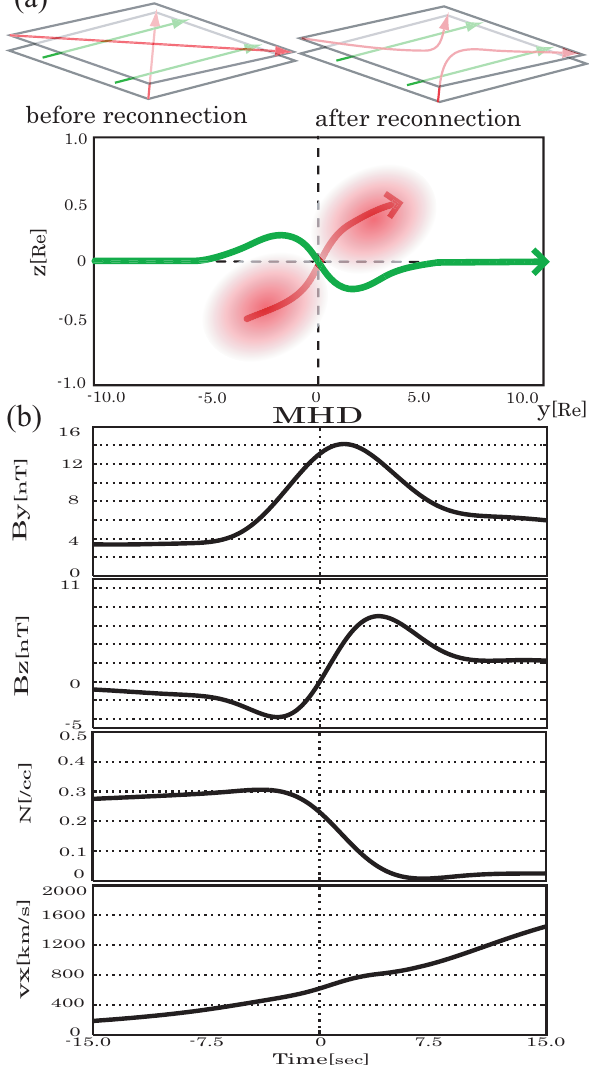
Fig. 32. (a) Schematic showing how negative B z can be produced at the jet leading edge. The red and green lines represent reconnected and current sheet embedded field lines, respectively. (b) Observa- tion by a virtual satellite situated at the current sheet center. The result is from an MHD simulation with the guide field B y 0 =4nT and the dawn-dusk extent of anomalous resistivity region of 3 R E . The initial half-thickness of the current sheet is set to be 0.5 R E . Note that the bipolar B z signature is reproduced, without invoking multiple reconnection X-lines. (From Shirataka et al.,